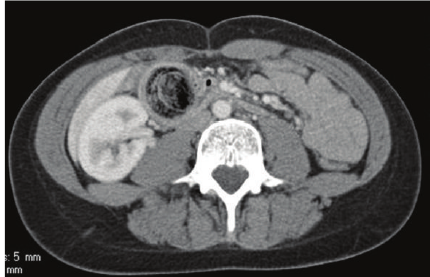
Figure 2: CT image showing bezoar extension from stomach into duodenum.